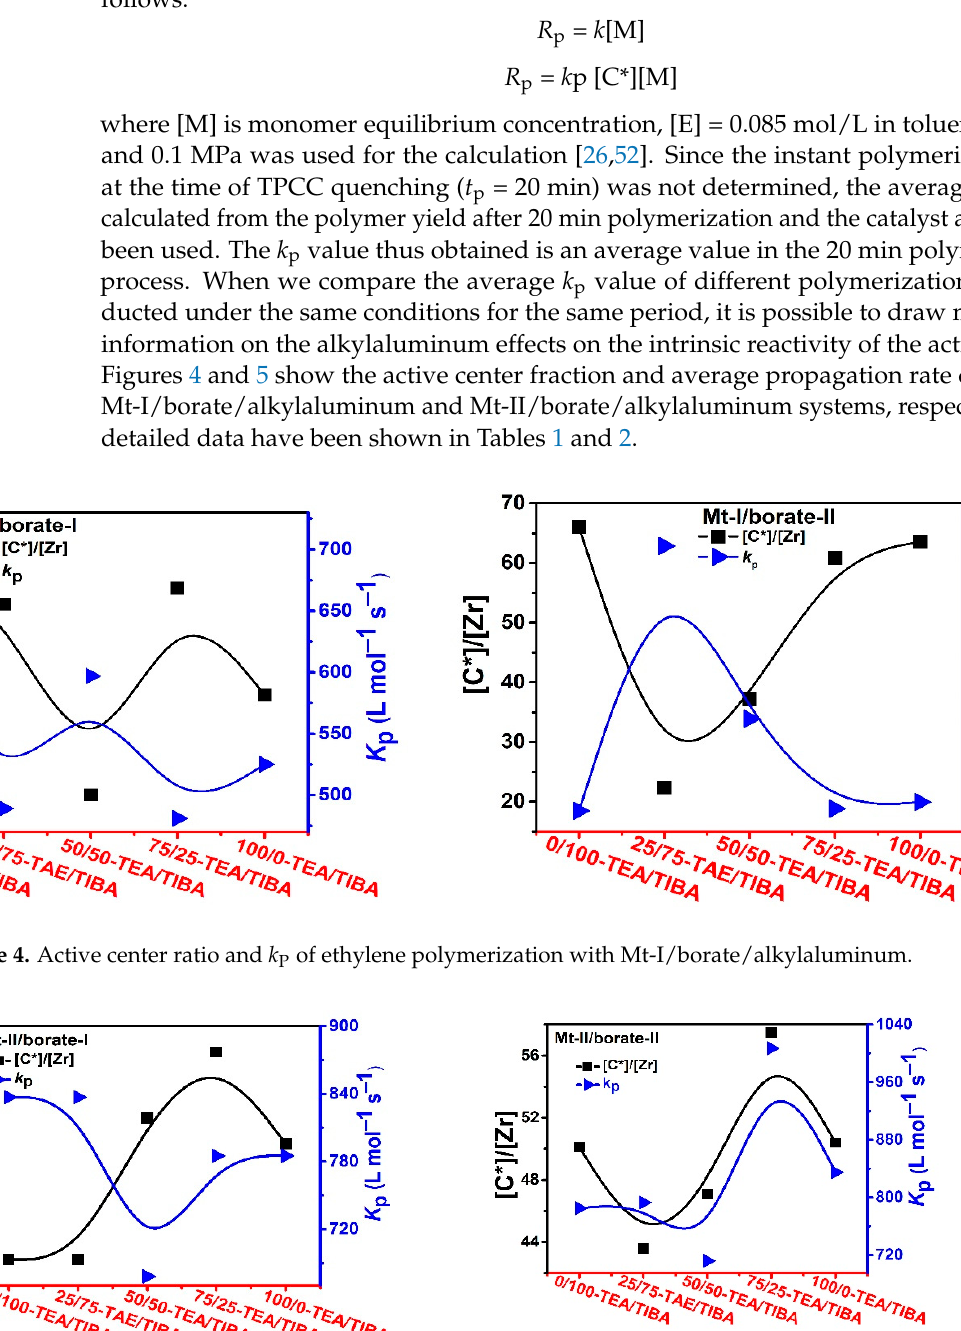
Figure 4. Active center ratio and k P of ethylene polymerization with Mt-I/borate/alkylaluminum.